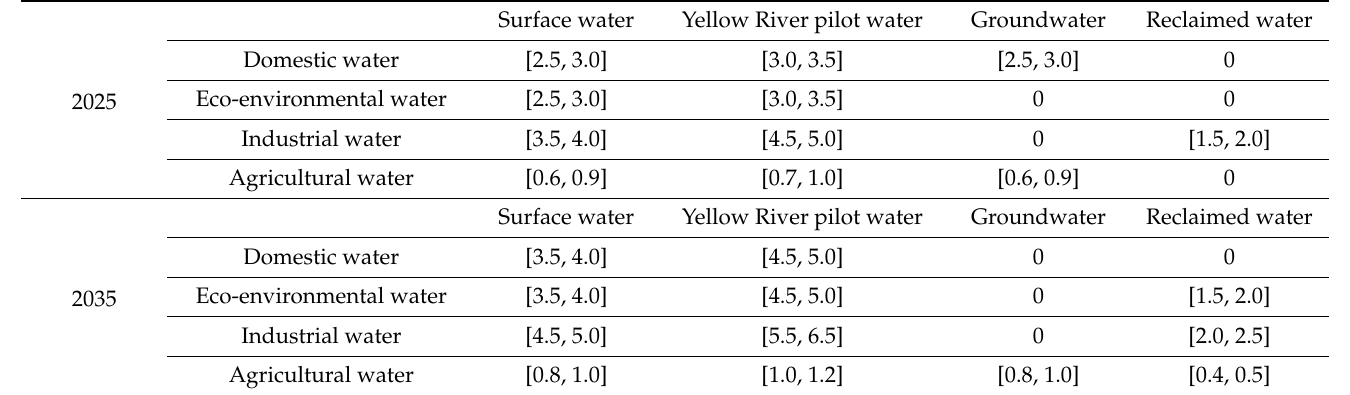
Table 4. Determination of the cost coefficient (yuan/m 3